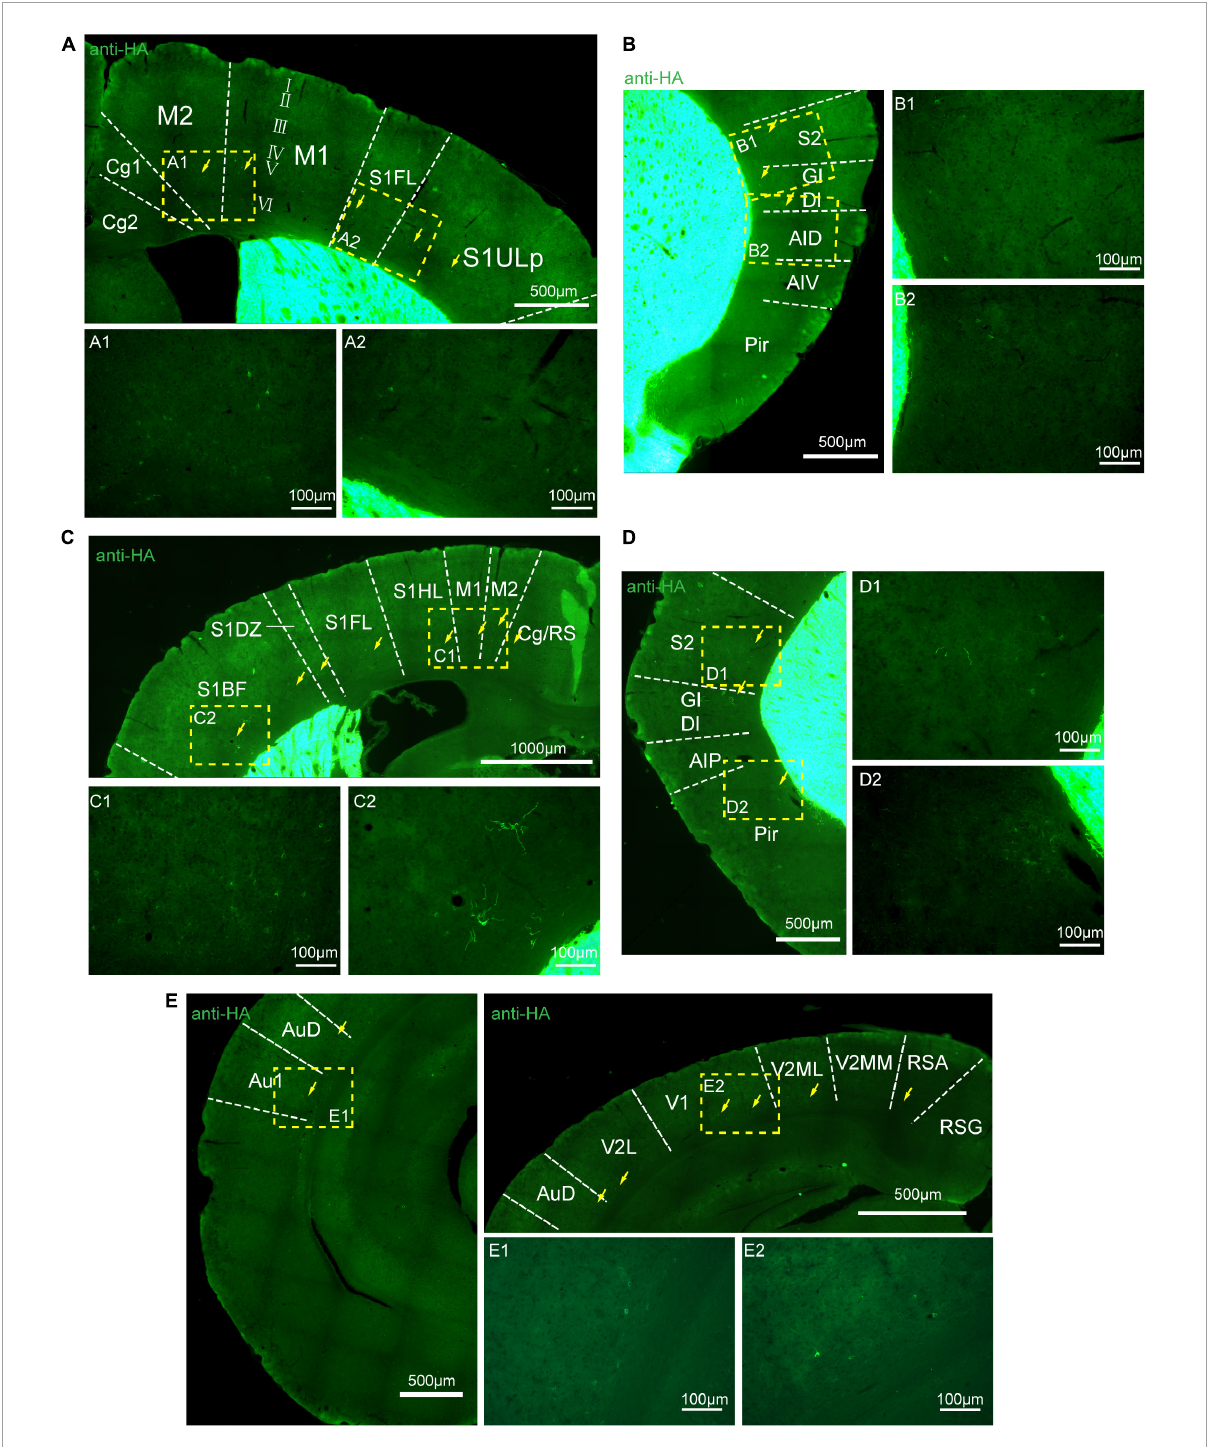
FIGURE8 Distribution of HA immunoreactivity in the cerebral cortex of adenosine A 2 A receptor (A 2A R)-tag mice. (A) Up: representative confocal image of HA expression in the motor and somatosensory cortex (0.5 mm before bregma). Discrete and bright labeled cells (arrows) could be seen in the deep layers (layer V or VI). Down: high magnification of the areas (A1,A2) in yellow indicated in panel (A) . (B, Left) Representative confocal image of HA expression in the somatosensory and agranular insular cortex (0.5 mm before bregma). Discrete and bright labeled cells (arrows) could be seen in the deep layers (layer V or VI). (Right) High magnification of the areas (B1,B2) in yellow indicated in panel (B) . (C, Up) Representative confocal image of HA expression in the motor and somatosensory cortex (0.7 mm before bregma). Discrete and bright labeled cells (arrows) could be seen in the deep layers (layer V or VI). (Down) High magnification of the areas (C1,C2) in yellow indicated in panel (C) . (D, Left)